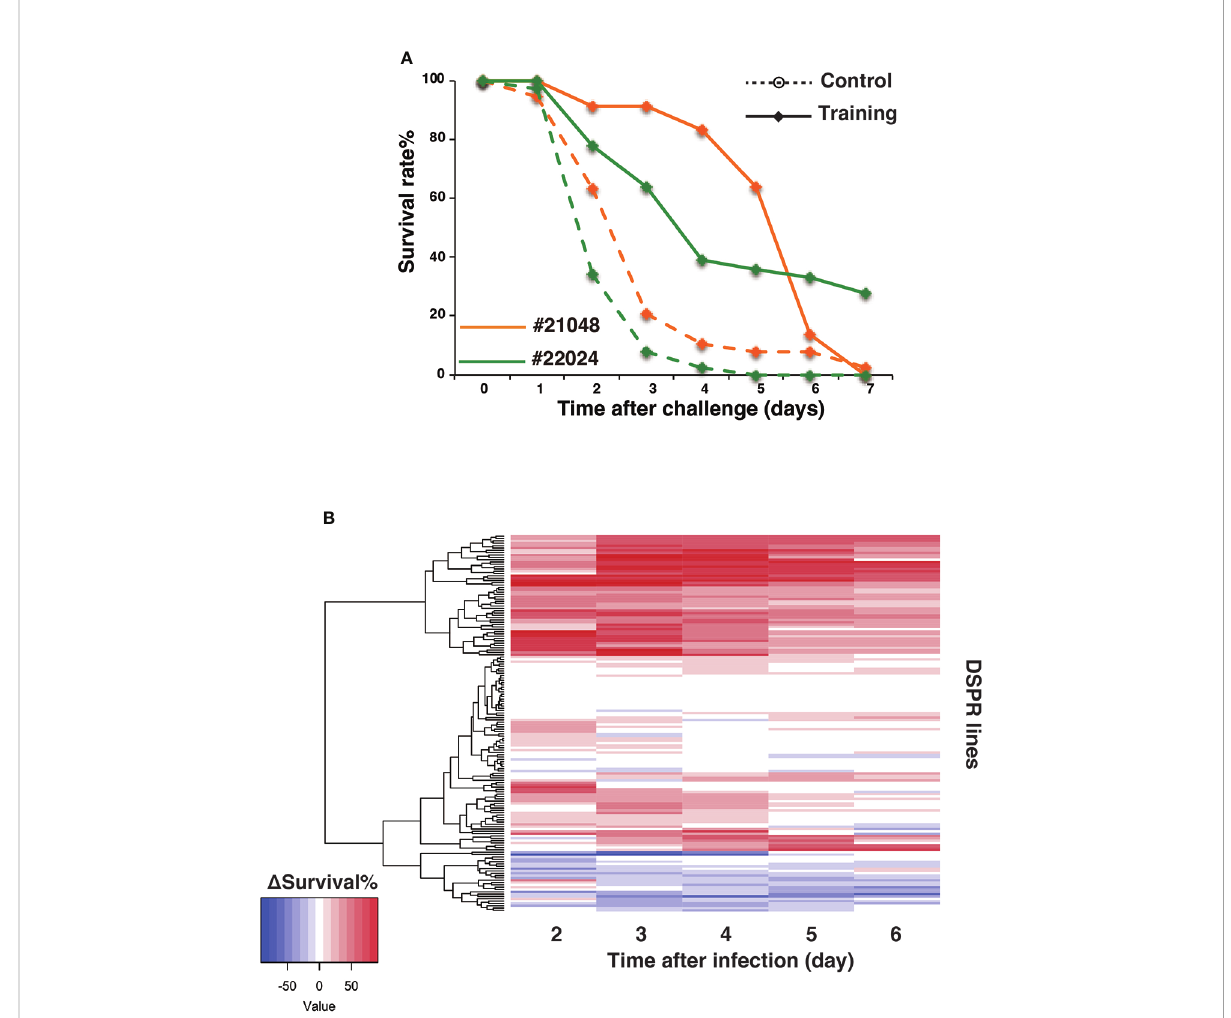
FIGURE 5 Variations in survival curves and D survival rates. (A) Data from DSPR lines #21048 (orange) and #22024 (green), representative of variations in survival curves. Survival rates under control and training conditions are marked by dashed and full lines, respectively. (B) Heatmap of D survival rates of 163 DSPR lines on days 2 to 6 after Sa challenge. 163 DSPR lines (rows) were aligned by the dendrogram of clustering analysis of D survival